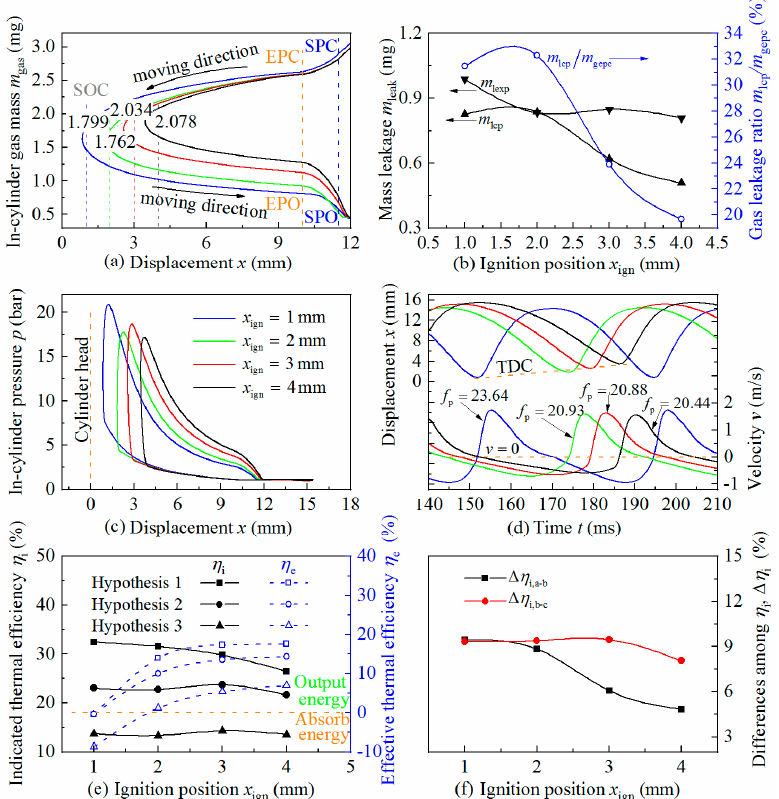
Figure 8. The influence of ignition position on leakage and system performance. ( a ) Mass variations of in-cylinder gas in function of stroke; ( b ) Mass leakage; ( c ) Pressure variations of in-cylinder gas in function of stroke; ( d ) Piston dynamic characeristics; ( e ) Thermal efficiencies; ( f ) Indicated thermal efficiency drops. Figure ( a , c , d ) apply the same legend displayed in figure ( c ). The blue, green, red and black solid lines stand for the ignition positions at 1.0, 2.0, 3.0 and 4.0 mm, respectively. The values in figure ( a ) show the exact amount of the in-cylinder gas mass at the corresponding positions. The symbol f p in figure ( d ) stands for piston frequency,